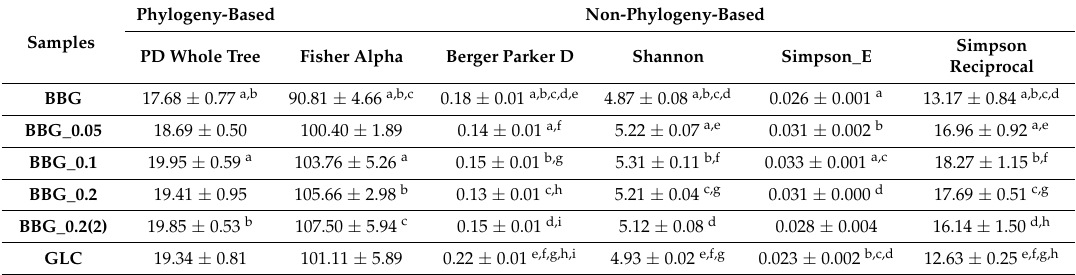
Table 4. Rarefied α -diversity indices of the infant faecal fermentation of 5 BBG samples and glucose